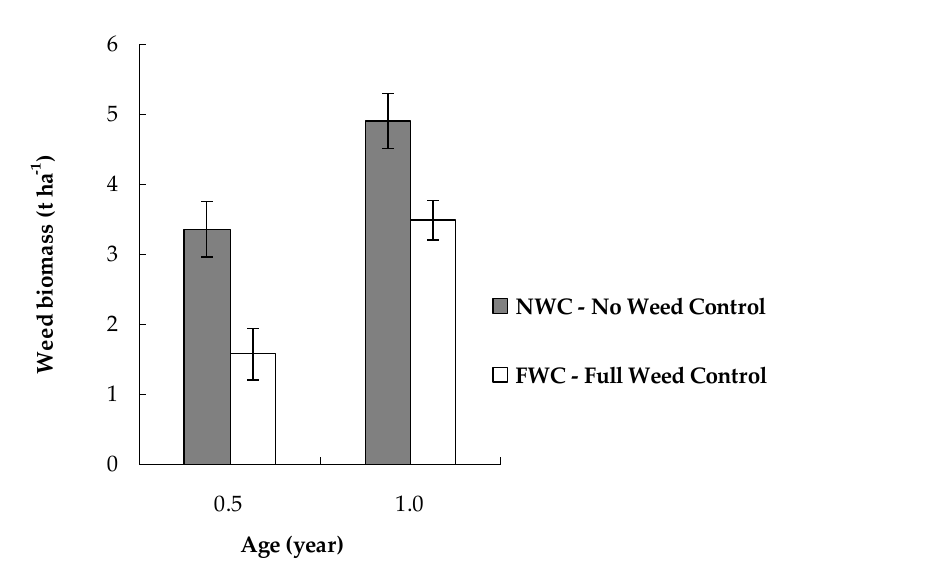
Figure 2. Weed biomass with different levels of weed control under Eucalyptus pellita plantation at Toman. Vertical bars are SE of means.